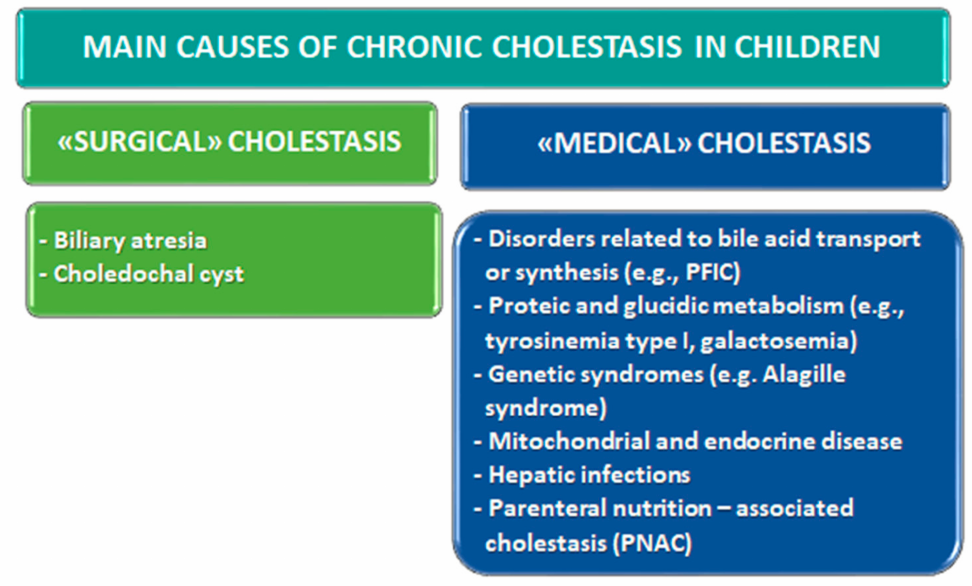
Figure 1. Main etiologies of prevalently extrahepatic (“surgical”) or intrahepatic (“medical”) pediatric chronic cholestatic liver disease. HFI, hereditary fructose intolerance; PFIC, progressive familial intrahepatic